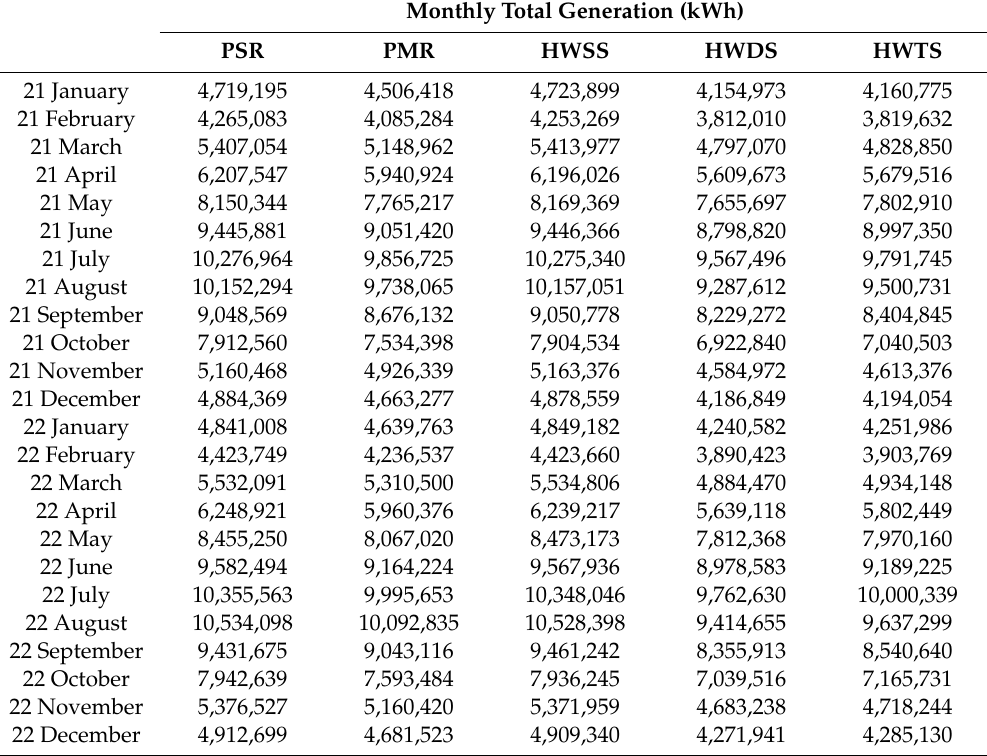
Table A2. The forecasted monthly generation of electricity for Kuwait between 2021 and